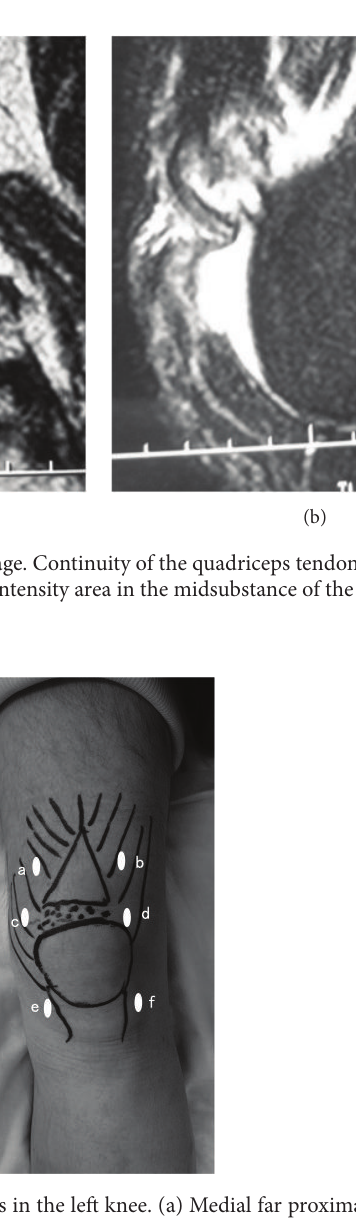
Figure 4: Location of arthroscopic portals. Portal locations in the left knee. (a) Medial far proximal portal. (b) Lateral far proximal portal.